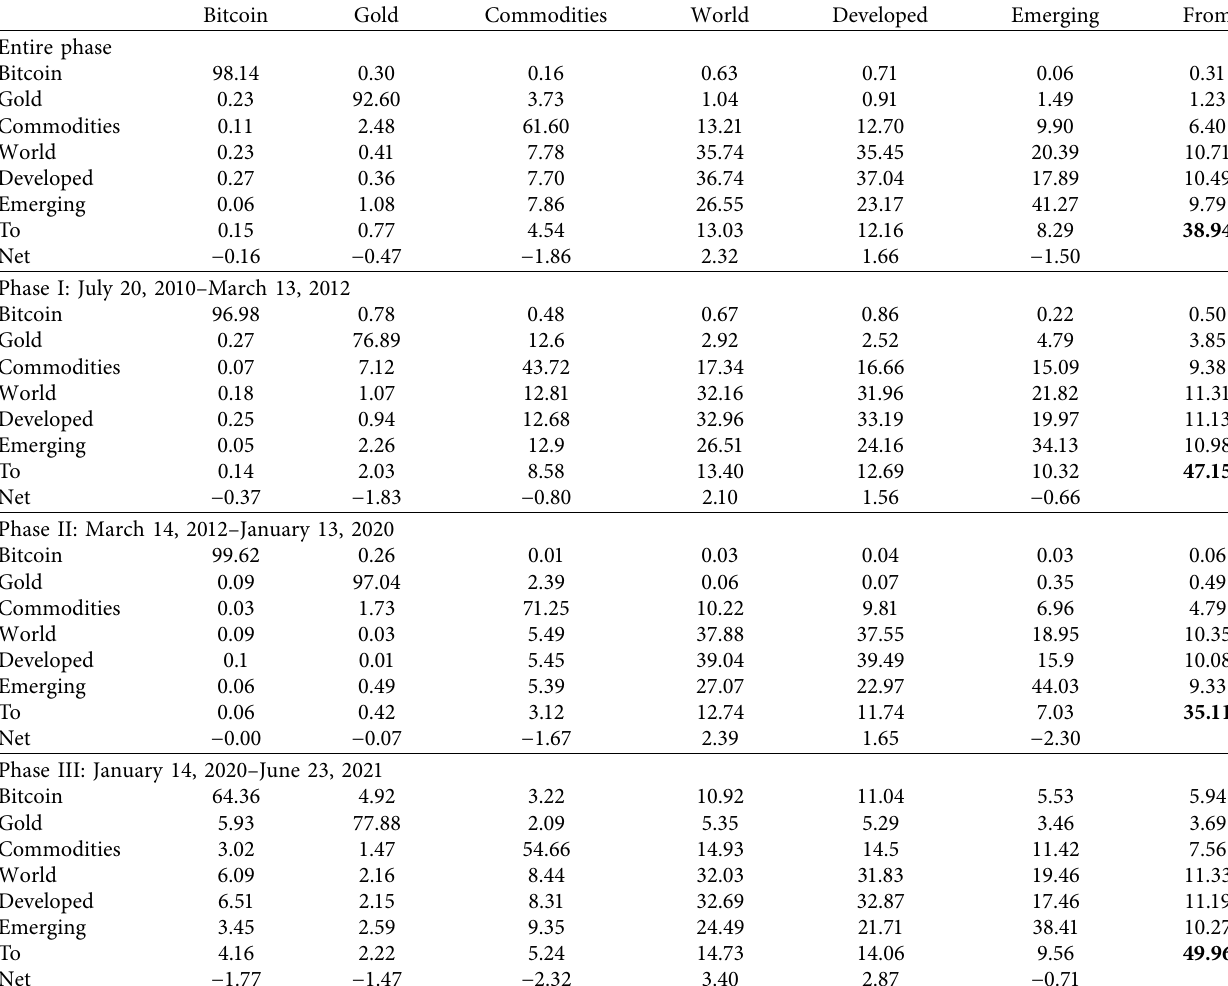
Table 2: Full-sample return spillover measures in the static time